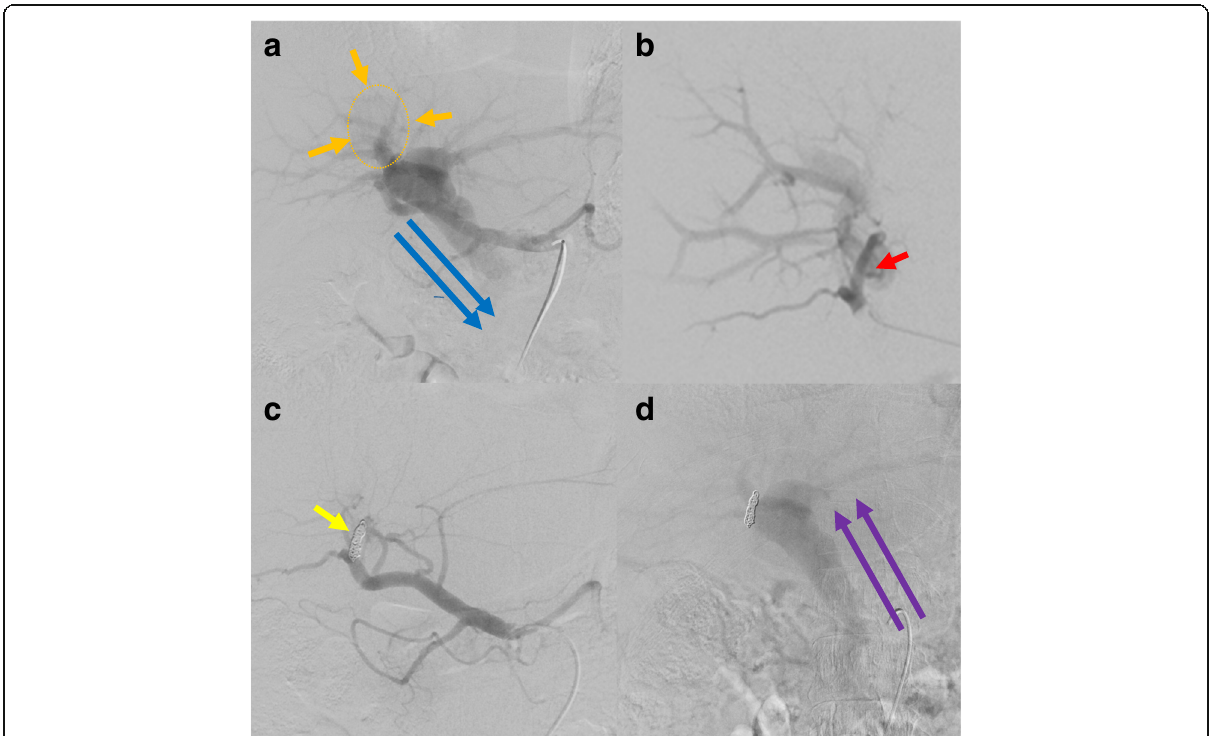
Fig. 5 Findings of angiography. a Angiography via the celiac artery was performed to create a portogram via the APF, and portography clearly revealed hepatofugal flow of the portal vein ( blue arrows ) . Portography also showed that the stump of the anterior portal vein had developed a PVA with a diameter of 40 mm ( orange arrows ) . b Selective catheterization of the common hepatic artery clearly demonstrated the APF at the stump of the anterior branches (red arrows). A definitive diagnosis of PVA due to APF was made. An adequate length of APF to perform embolic therapy was confirmed. c Selective embolization of the anterior hepatic artery was accomplished by placement of several titanium coils (yellow arrow). Blood flow through the APF was drastically reduced. d Arteriography via the superior mesenteric artery showed hepatopetal portal flow (purple